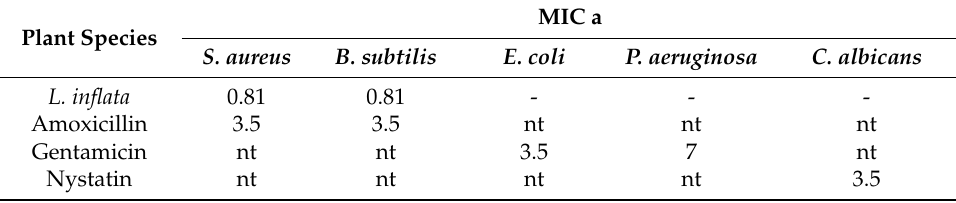
Table 2. Antimicrobial activity (minimal inhibitory concentrations (MIC-values)) of the essential oil of L. inflata .